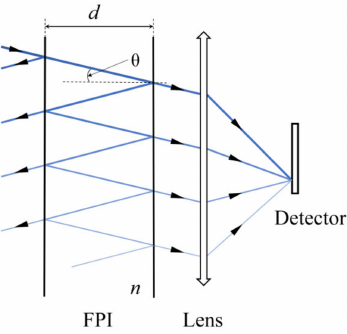
Figure 1. Schematic diagram of the FPI